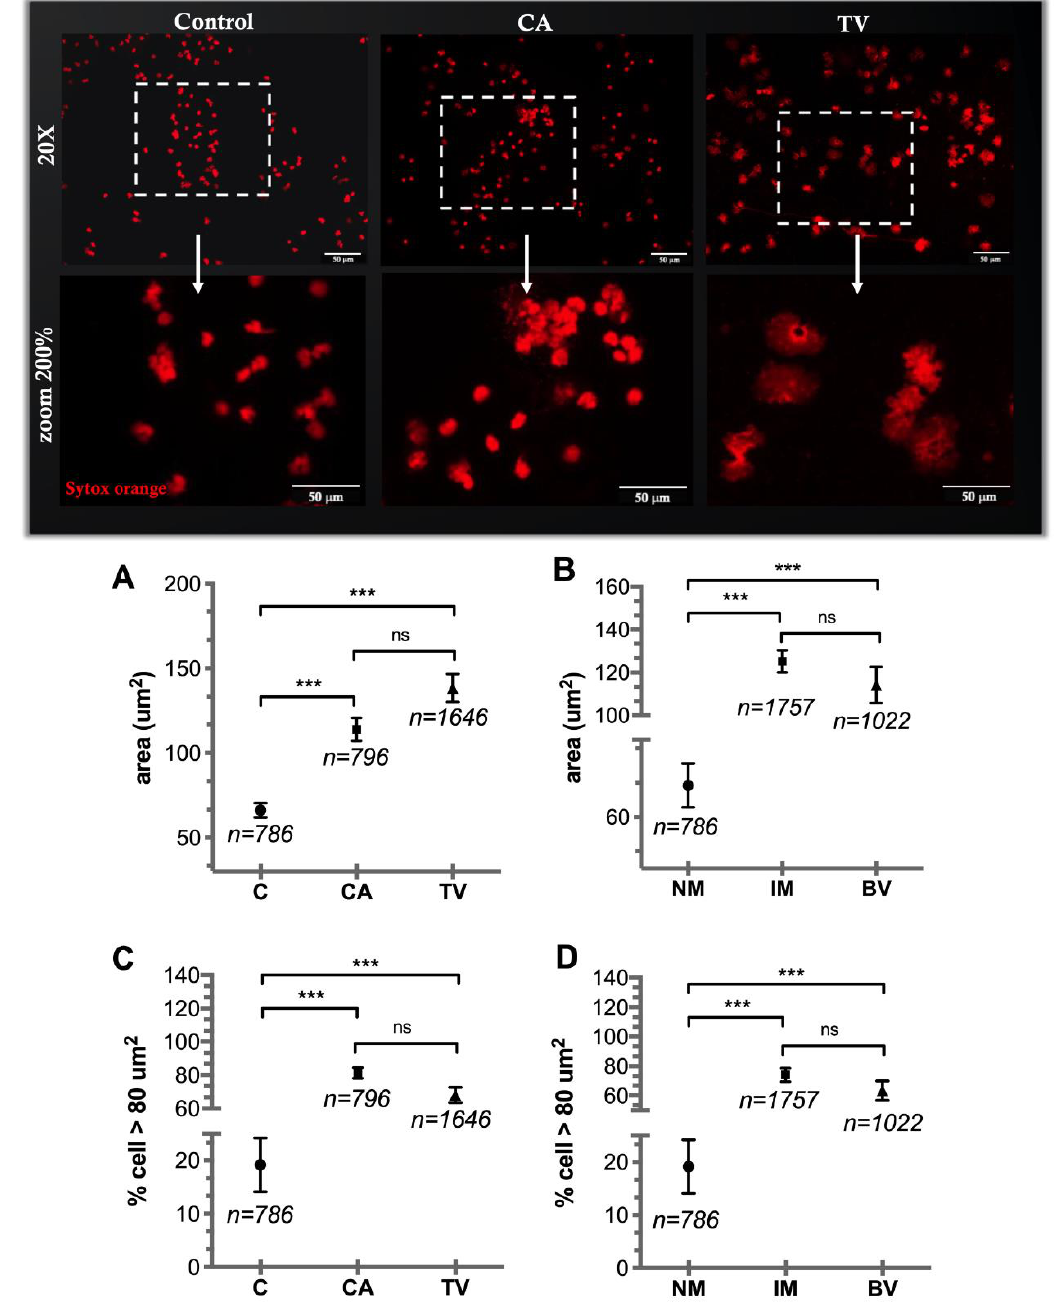
Figure 3. Nuclear PMN analysis of pathological vaginal discharges. The microscopic images show nuclear staining with Sytox Orange (red fluorescence) at 20 × and 200 × magnification. Graphs in ( A ) and ( B ) show average sizes of the cells analyzed in µ m 2 grouped into discharges diagnosed as CA and TV and classified according to characteristics of the microbiota, respectively. Graphs in ( C , D ) show percentages of cells with nuclei greater than 80 µ m 2 grouped according to pathology and microbiota, respectively. The data are indicated as mean ± SD; the total number of analyzed cells in each column is indicated (*** p < 0.001).